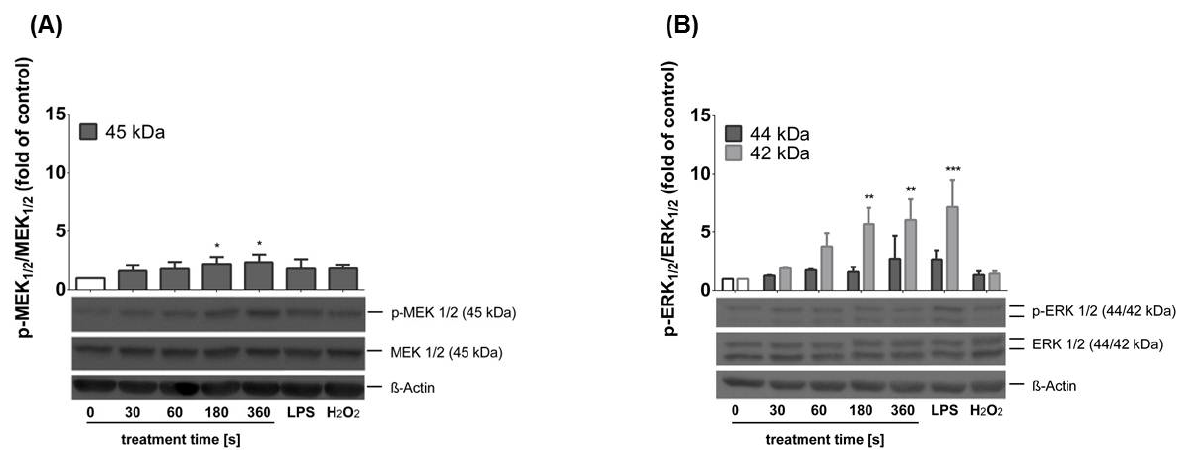
Figure 2 : Western blot analysis of the MEK-ERK signaling pathway. Human monocytes were lysed after 15 min of plasma treatment. Subsequently, Western blot analysis was performed with the protein suspensions to determine the phosphorylated as well as the total level of the proteins MEK 1/2 at 45 kDa (A) and ERK 1/2 at 44 and 42 kDa (B). Relative phosphorylation level was calculated as a ratio of phosphorylated to total protein and plotted as bar diagrams. H O (100 μM) and LPS (1 μg mL -1 ) treated samples served as controls for apoptotic and proliferative 2 2 pathways. All samples were normalized to the untreated control (0 s). β-Actin (45 kDa) was used as a loading control. Data from three